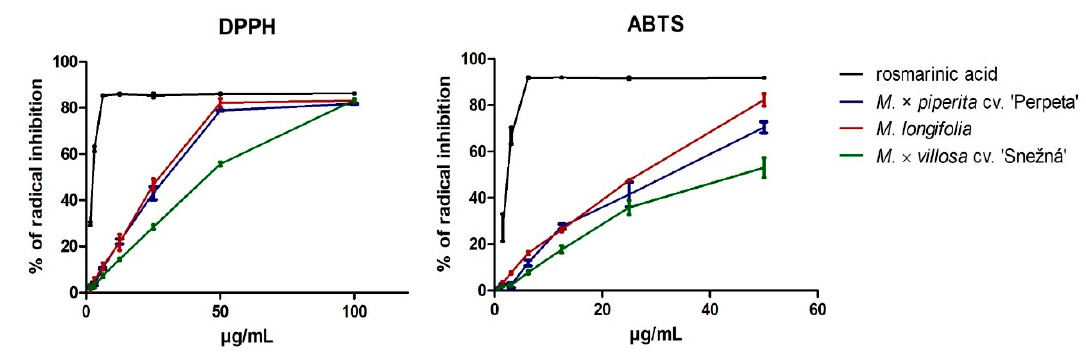
Figure 1. Dose-dependent DPPH and ABTS radical inhibition of single mint extracts and rosmarinic acid. The bars represent mean ± SD , n = acid. The bars represent mean ± SD , n = 4.